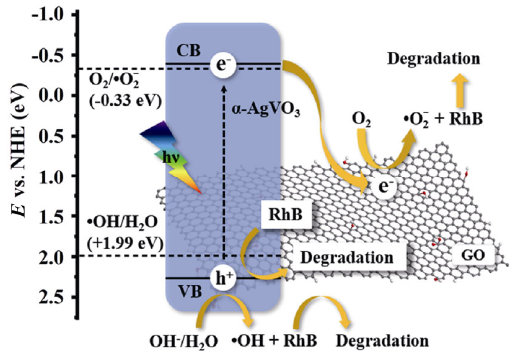
Fig. 13 Proposed photocatalytic mechanism of GO/ α -AgVO 3